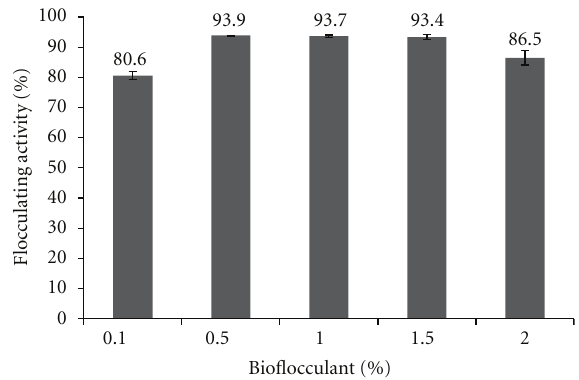
Figure 4: Flocculating activity based on di ff erent bioflocculant dosage supplied with the range of 0.1–2.0% from total volume of